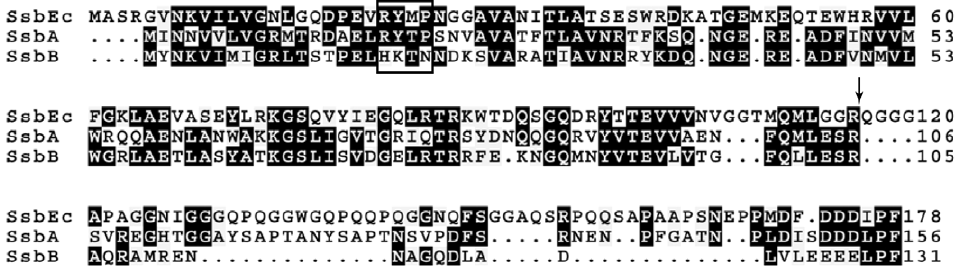
Figure 1. Streptococcuspneumoniae SsbA and SsbB proteins. The amino acid sequences of the S. pneumoniae SsbA and SsbB proteins are aligned with that of the E. coli SSB protein, SsbEc. Identical residues are highlighted in black. The division between the N-terminal and C-terminal domains is indicated by an arrow, and the putative Loop 1 region is denoted with a box.